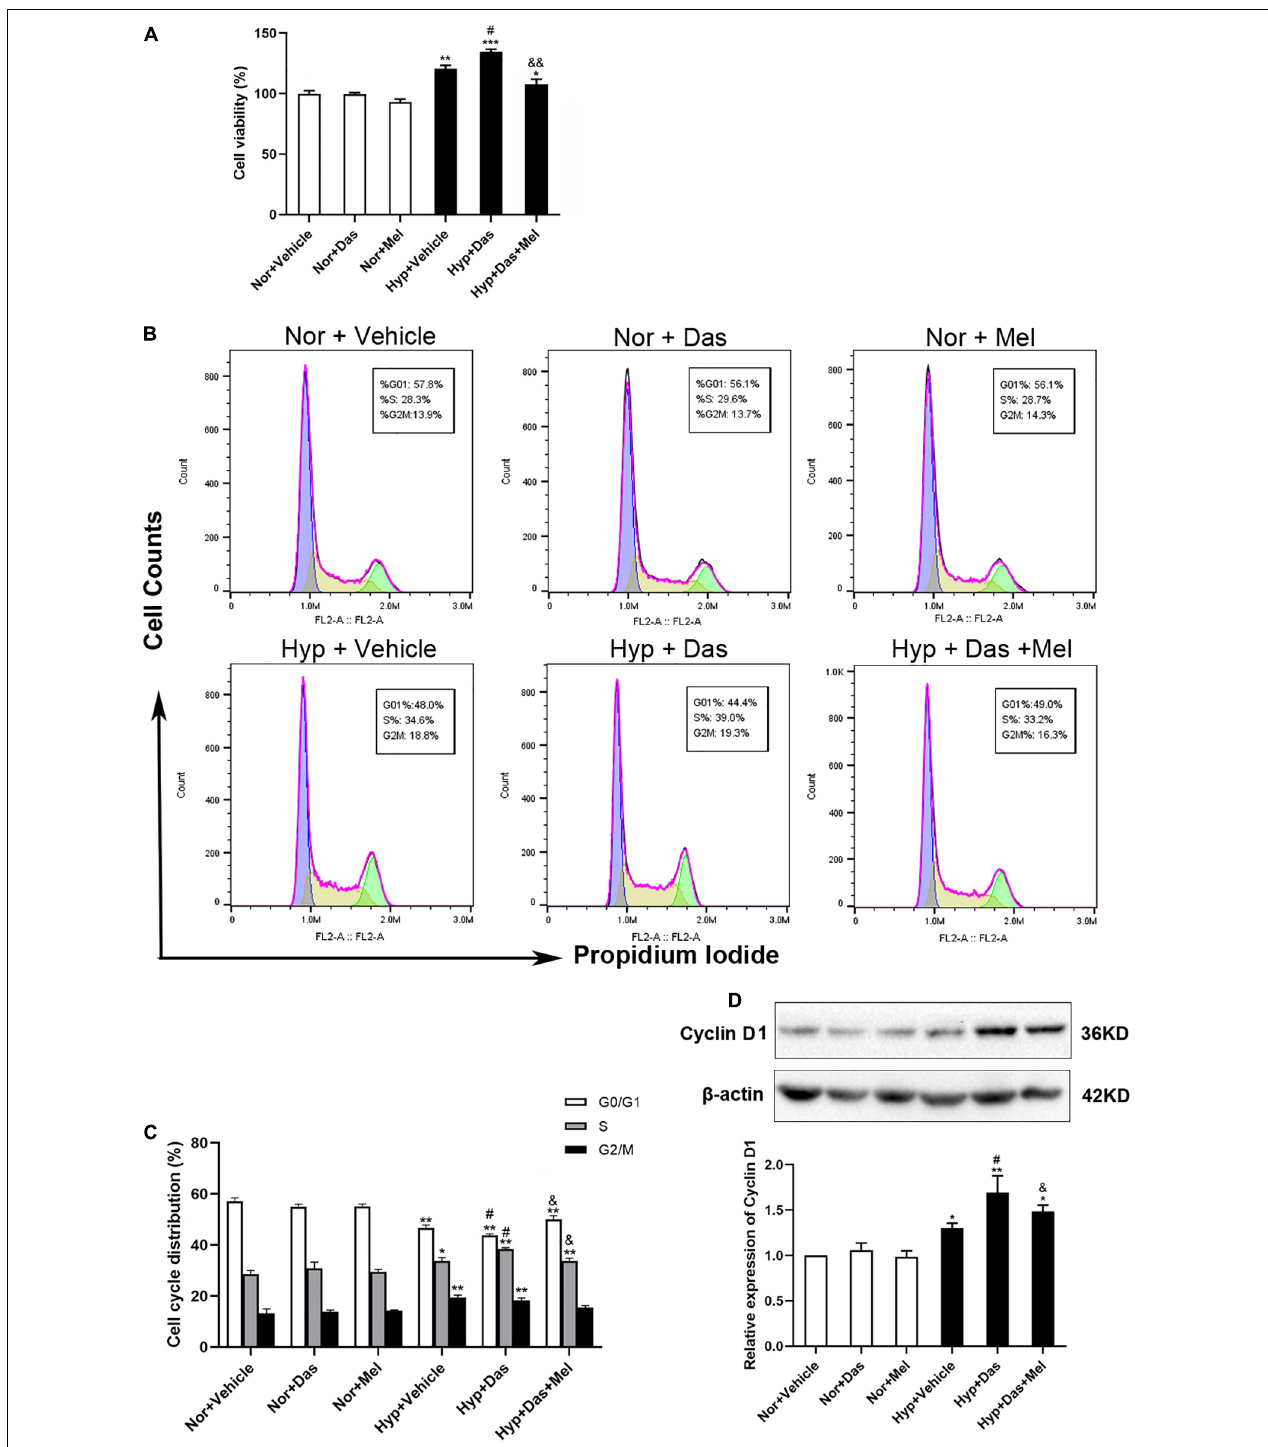
FIGURE 8 | Melatonin arrests cell cycle process acceleration of pulmonary artery smooth muscle cells (PASMCs) induced by dasatinib under hypoxia. Viability of PASMCs pretreatment with melatonin or vehicle induced by dasatinib under hypoxia for 24 h was determined by cell counting kit-8 (CCK8) assay (A) . Representative FACS dot plots of cell cycle in PASMCs (B) , the percentage of cells at each phase of cell cycle was quantified (C) . Protein expression of Cyclin D1 in PASMCs (D) . Values are means ± SEM, ***P < 0.001, **P < 0.01, *P < 0.05 compared with Nor + Vehicle group. # P < 0.05 compared with Hyp + Vehicle group. && P < 0.01, & P < 0.05 compared with Hyp + Das group ( n =